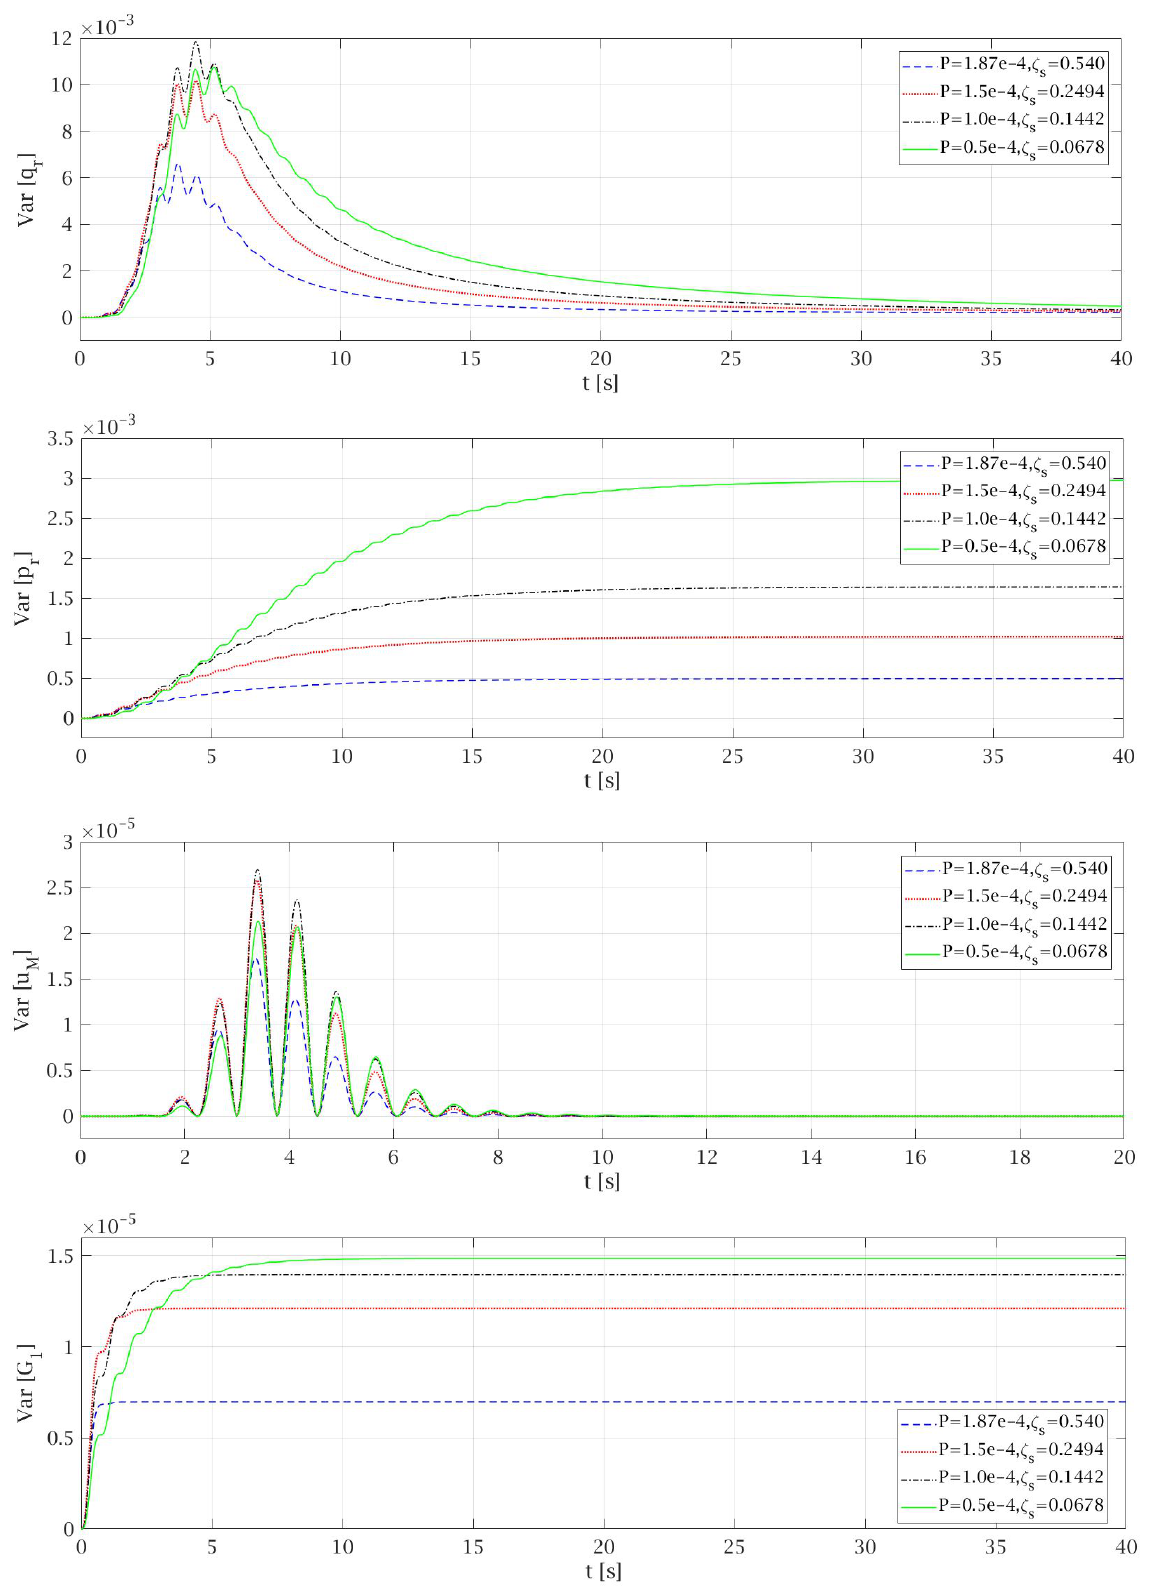
Figure 4. Variances of particular random state variables obtained by the equivalent linearization technique for different values of P and ζ s